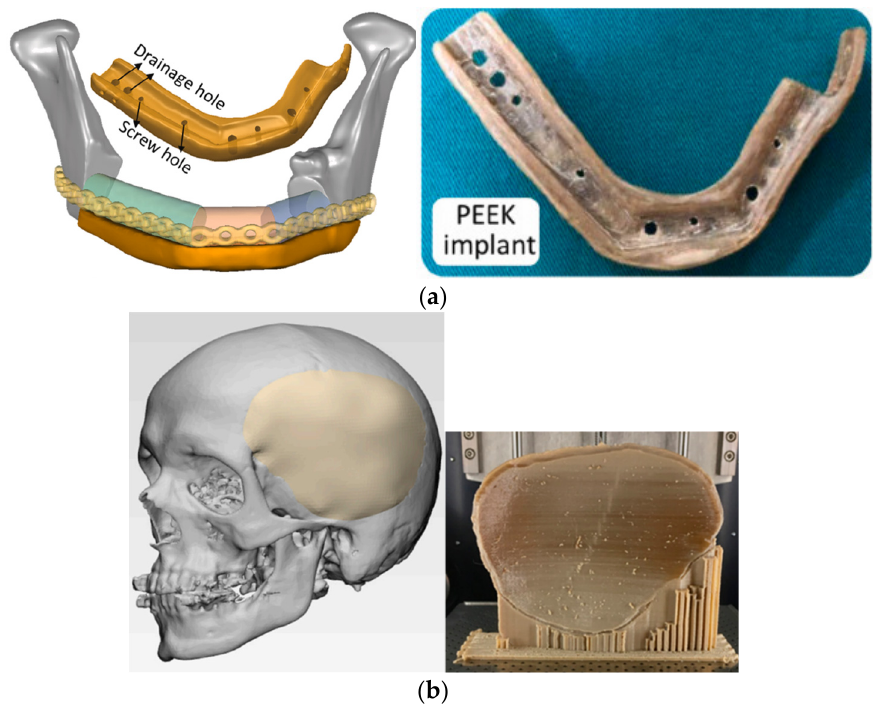
Figure 33. Two types of PEEK implants: ( a ) mandible implants 197 and ( b ) cranial bone implants 131 .